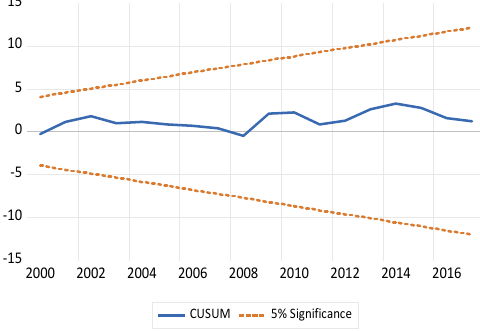
Figure 2. CUSUM test for the linear ARDL model.